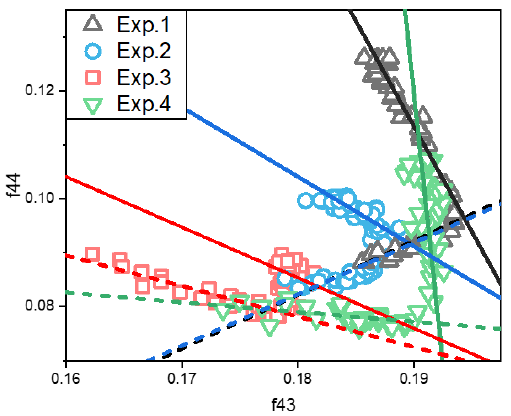
Figure 3. The relationship between total organic signals at 43 m/z ( f 43 ) vs. 44 m/z ( f 44 ) from SOA data during the photooxidation process. The f 43 vs. f 44 plots exhibited inflection points during the photooxidation process. The dashed lines indicate the trends of f 43 vs. f 44 for the SOA formation stage (before the inflection point), and the solid lines are for the stable